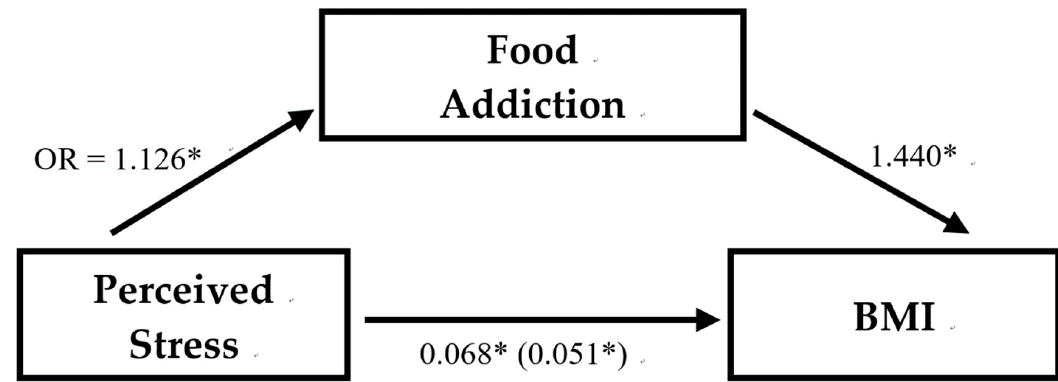
Figure 4. The association between perceived stress, food addiction, and BMI. Perceived stress = perceived stress scale with range 0–40; Food addiction = food addiction or non-food addiction recognized by Yale Food Addiction Scale; BMI = Body Mass Index (kg/m 2 ). Regression coefficients of multiple linear regressions are unstandardized and the coefficient for the indirect relationship between perceived stress and BMI controlling for food addiction in parentheses. The indirect effect size of perceived stress on BMI through FA is 25.18%. * p < 0.01.